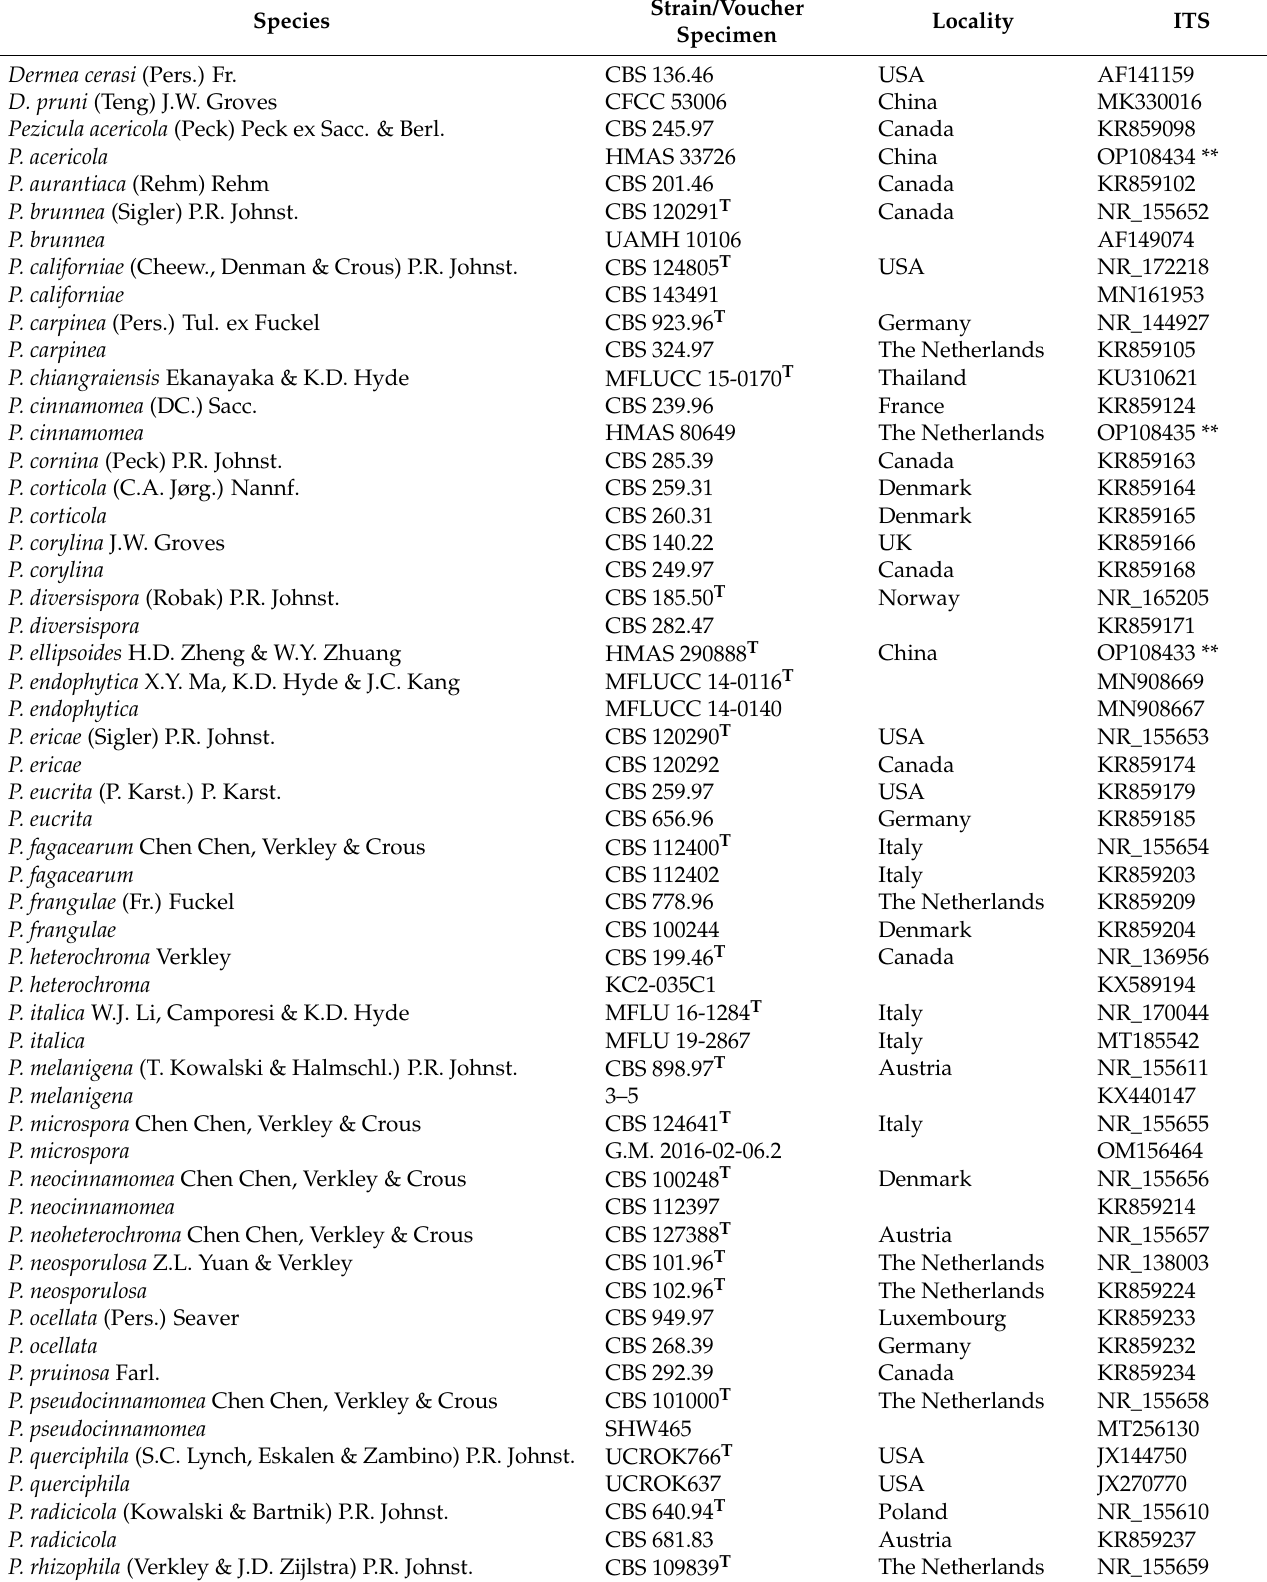
Table 1. List of taxa and GenBank accession numbers of ITS sequences used in the study. Strain/Voucher Locality ITS Species Specimen Dermea cerasi (Pers.) Fr. CBS 136.46